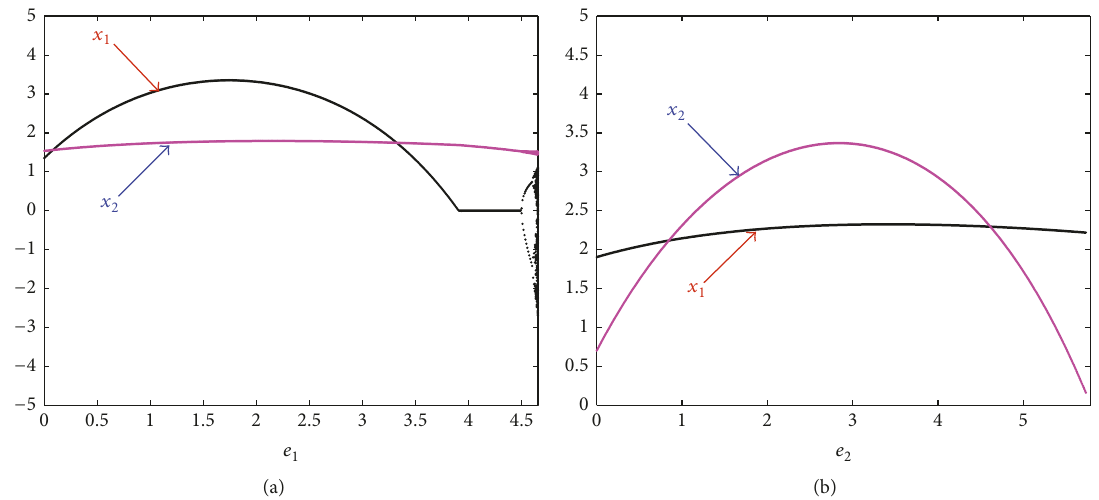
Figure 11: Bifurcation diagram for (a) 𝑒 1 ∈ (0, 4.6531] ; (b) 𝑒 2 ∈ (0,5.7857] and (𝛼 1 = 0.42, 𝛼 2 = 0.36) .